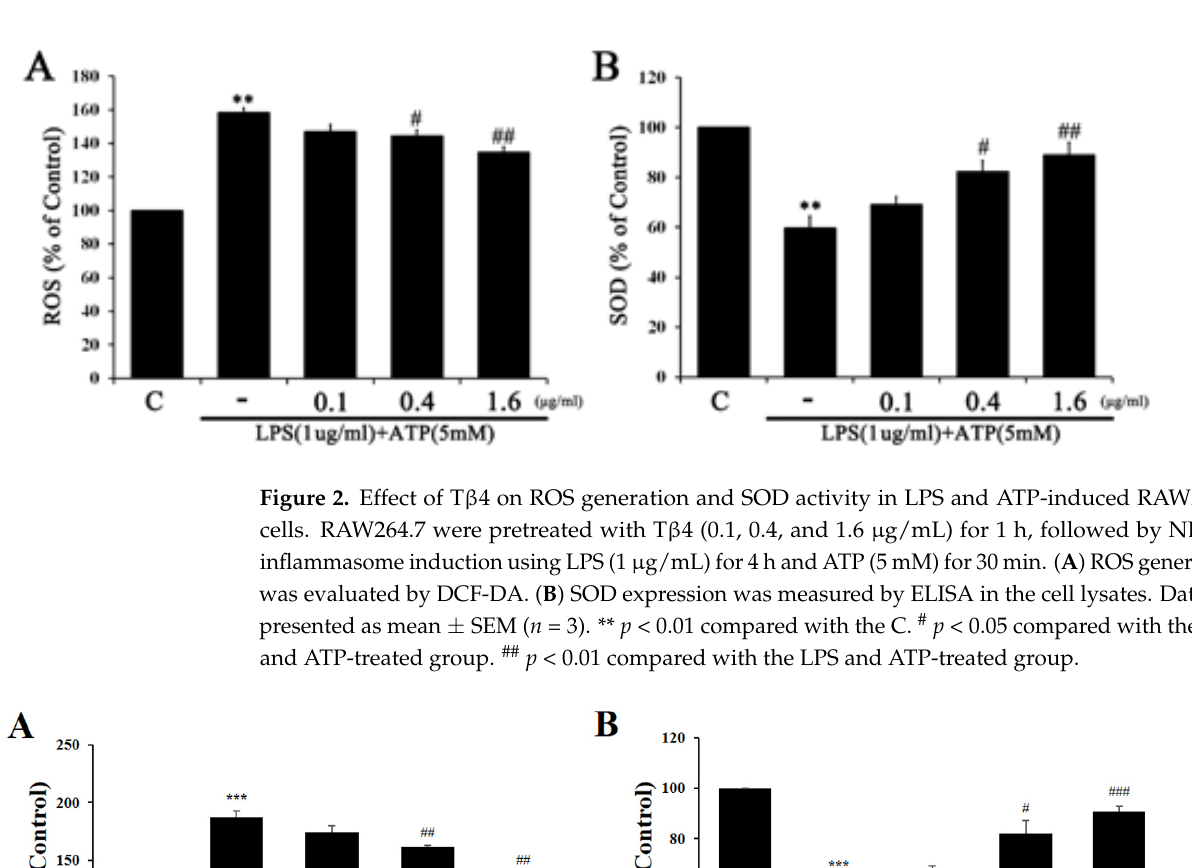
Figure 2. Effect of T β 4 on ROS generation and SOD activity in LPS and ATP ‐ induced RAW264.7 cells. RAW264.7 were pretreated with T β 4 (0.1, 0.4, and 1.6 μ g/mL) for 1 h, followed by NLRP3 tion was evaluated by DCF ‐ DA. ( B ) SOD expression was measured by ELISA in the cell lysates. Data are presented as mean ± SEM ( n = 3). ** p < 0.01 compared with the C. # p < 0.05 compared with